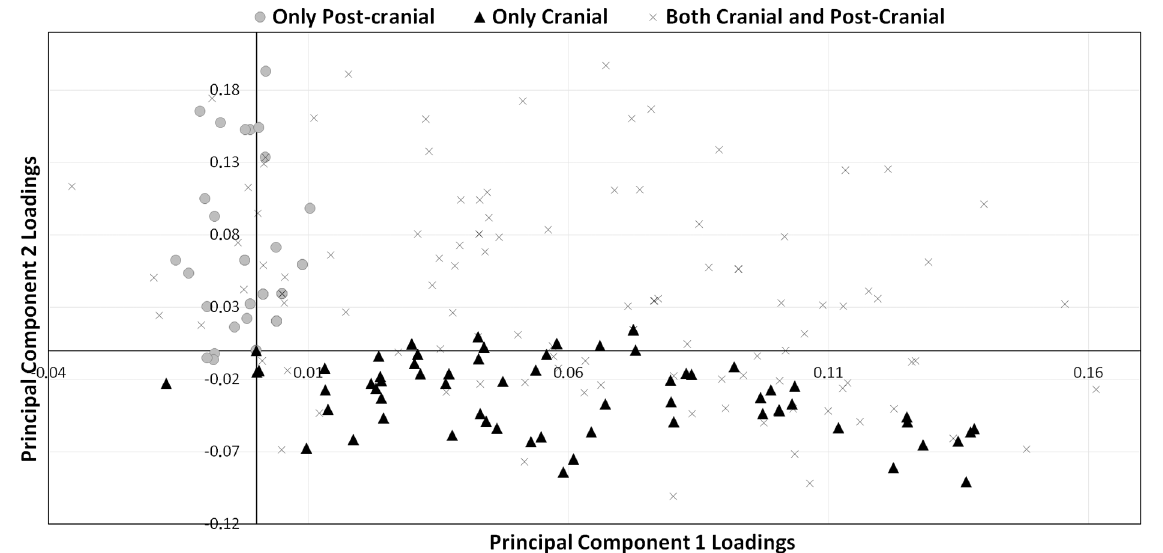
Figure 6. PCA factor loadings (PC1 and PC2) of taxa described with only post-cranial (circle), cranial (triangle) and both cranial and post-cranial (cross) osteological